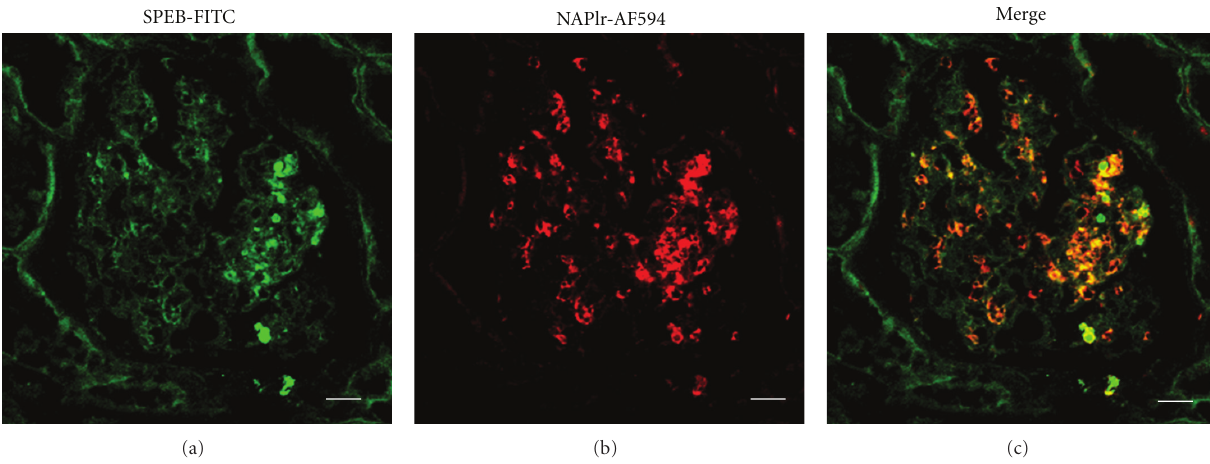
Figure 6: Representative photomicrographs of double IF staining for streptococcal pyrogenic exotoxin B (SPEB) ((a), FITC) and NAPlr ((b), Alexa Fluor 594) in an APSGN patient. A similar but not identical distribution of NAPlr and SPEB was observed in the merged image (c). Generally, NAPlr staining results were rather stronger than SPEB staining results (scale bar = 20 μ